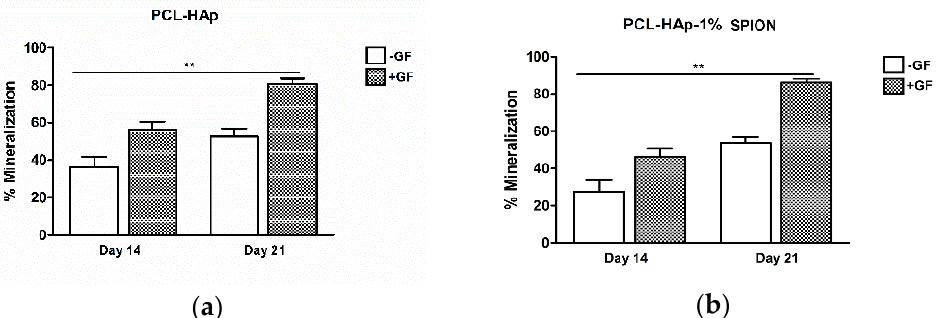
Figure 6. ( a ) Graphical representation of % mineralization of MSCs seeded onto PCL-HAp and cultured with (+) and without ( − ) growth factors (GF) at 14 and 21 days. Data are expressed as mean ± SD. Kruskall-Wallis and post hoc Dunn’s test were used for statistical analysis. ** p < 0.01 PCL-HAp cultured − GF on day 14 versus PCL-HAp + GF on day 21. ( b ) Graphical representation of % mineralization of MSCs seeded in PCL-HAp-1%SPION and cultured +/ − GF on days 14 and 21. Data are expressed as mean ± SD. Kruskall-Wallis and post hoc Dunn’s test were used for statistical analysis. ** p < 0.01 PCL-HAp-1%SPION cultured − GF on day 14 versus PCL-HAp-1%SPION +GF on day 21.